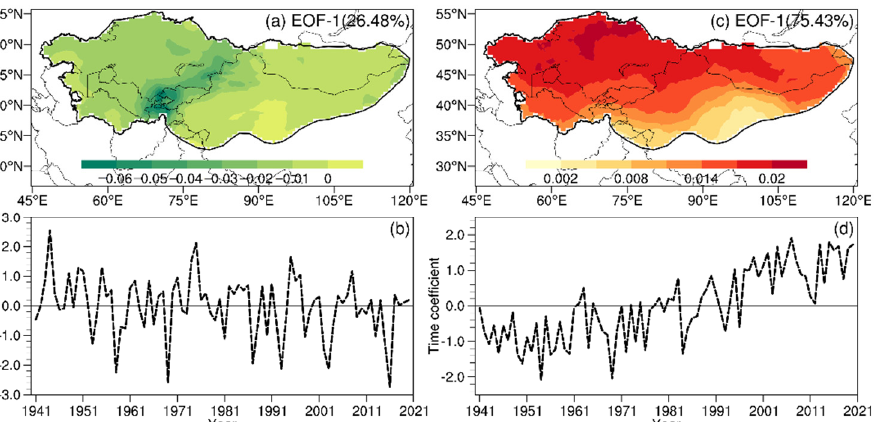
Figure 10. The first leading spatial mode and time series of precipitation anomaly field ( a , b ) and temperature anomaly field ( c , d ) derived from EOF decomposition in the Pan-Central-Asia arid region—all have passed the North significance test.